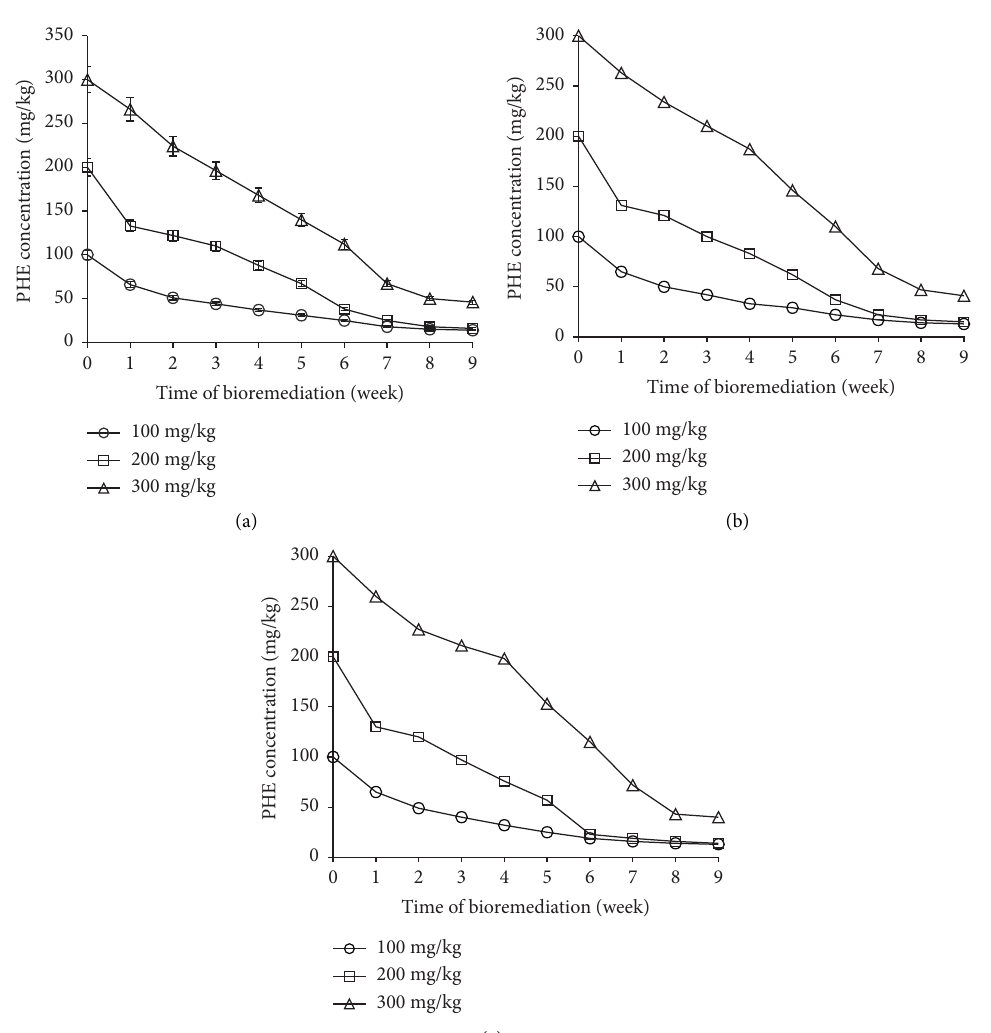
Figure 1: PHE concentrations in vermicompost of (a) 2%, (b) 4%, and (c)